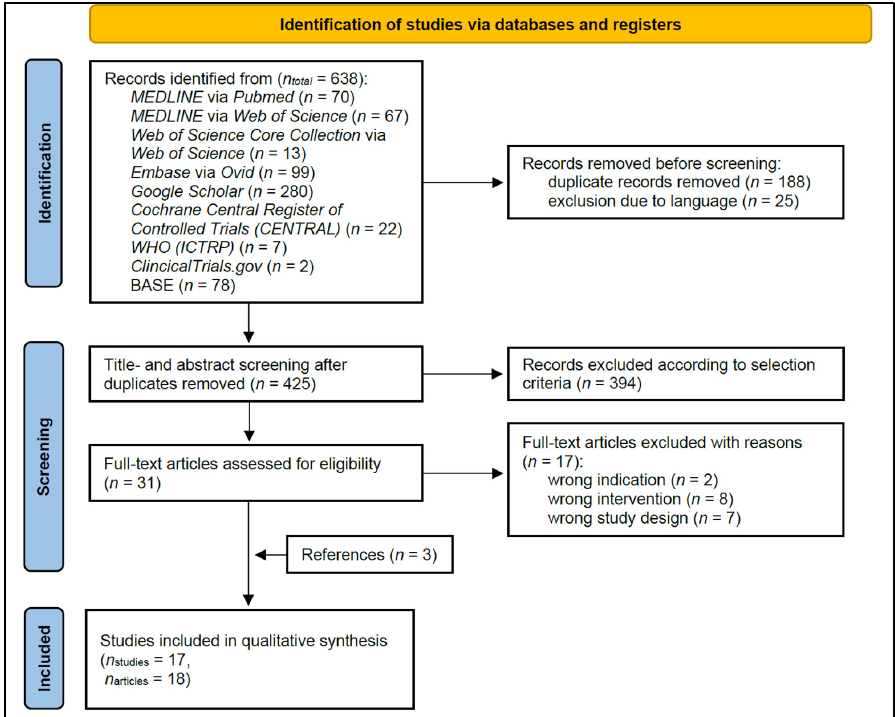
Figure 1. PRISMA flow diagram of the literature search, screening, and inclusion process, which included searches of databases and registers. included searches of databases and